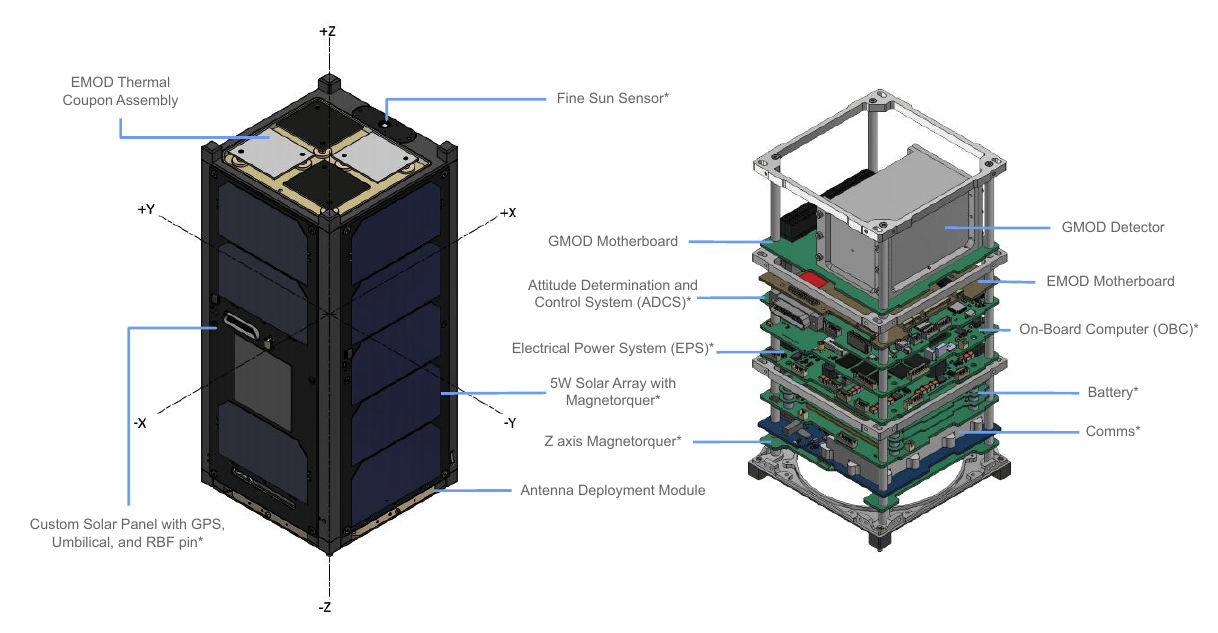
Figure 1. Illustration of EIRSAT-1 and the internal printed circuit board (PCB) stack. Labels marked with an asterisks are commercial off-the-shelf (COTS) components. All other components are designed and assembled in